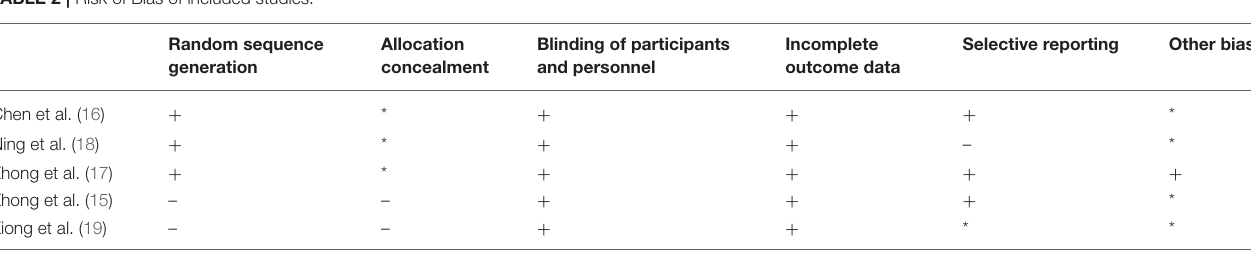
TABLE 2 | Risk of Bias of included studies.